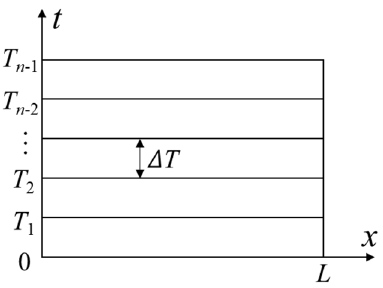
Figure 2. Division of space–time domain.